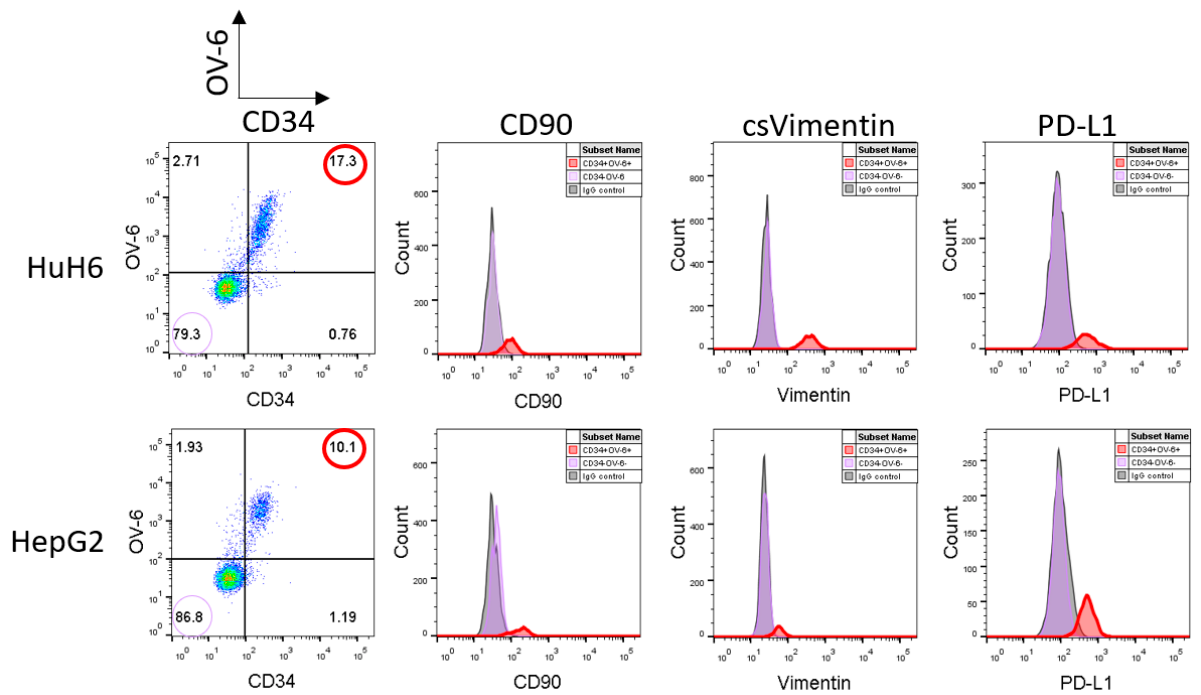
Figure 1. CD34 + OV-6 + CD90 + csVimentin + CSCs of hepatoblastoma cell lines express PD-L1. HuH6 and HepG2 cells were simultaneously analyzed for OV-6 binding and CD34 expression along with CD90, csVimentin and PD-L1 expression, respectively, using flow cytometry. The cells were first gated into CD34 + OV-6 + (red line) and CD34 − OV-6 − (violet line) cells and subsequently analyzed for CD90, csVimentin or PD-L1 expression. These are representative results of at least 5